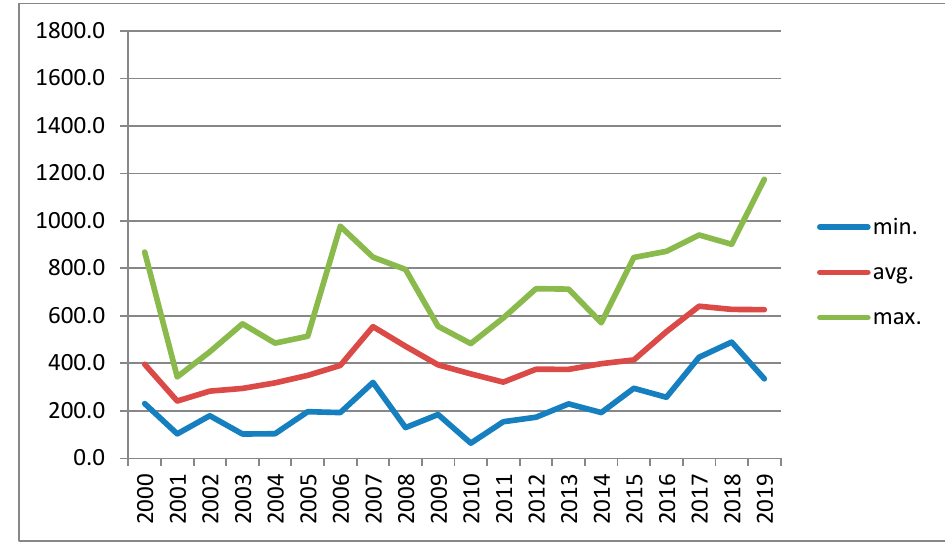
Figure 5. Annual wood prices (USD/m 3 ) of Oak wood offered at the Krosno submission.